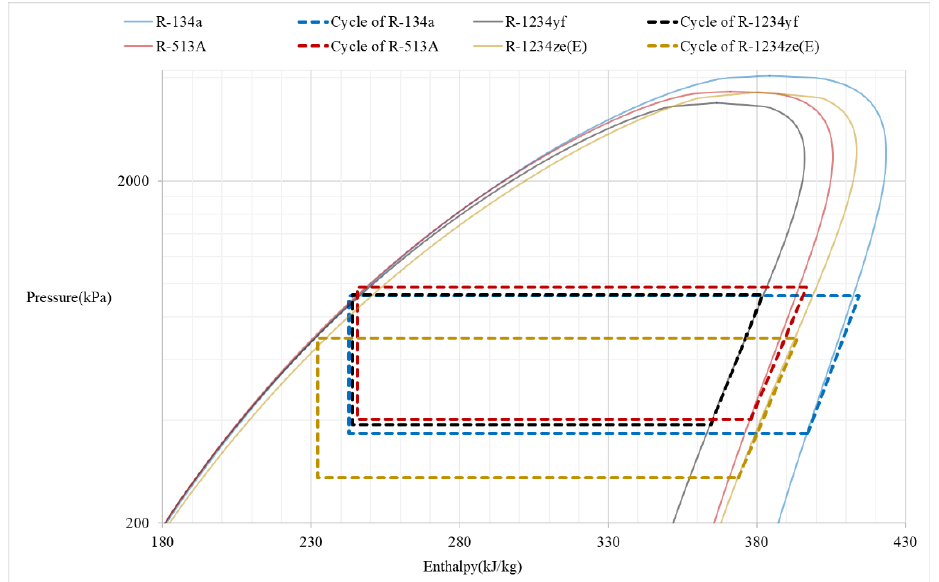
Figure 2. Refrigerants pressure–enthalpy comparison diagram. Table 1. Physical properties of R-134a refrigerant and R-513A refrigerant [22].